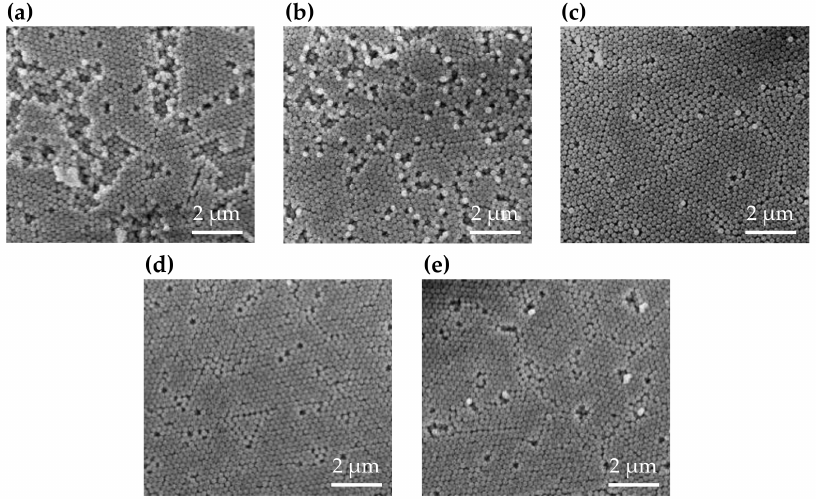
Figure 6. Scanning electron microscope (SEM) images of structures stacked with a 50 wt % silica colloidal solution under centrifugal forces of ( a ) 0; ( b ) 7; ( c ) 14; ( d ) 18; and ( e ) 21